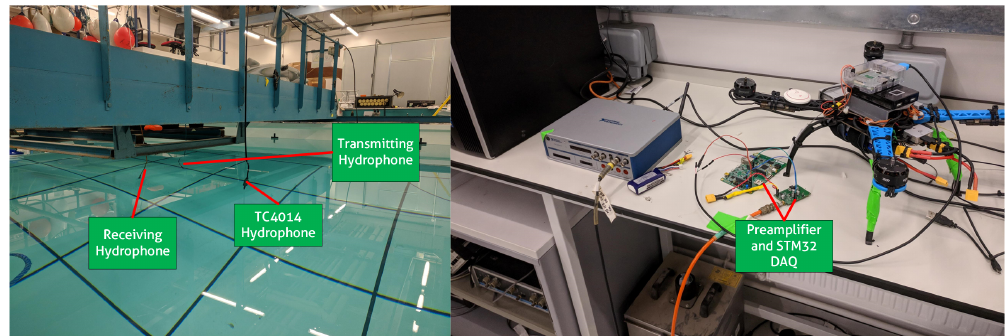
Figure 9. Indoor tank setup of the source transducer, PorpDAQ and reference system. Table 1. Specification of both the data acquisition system and the reference